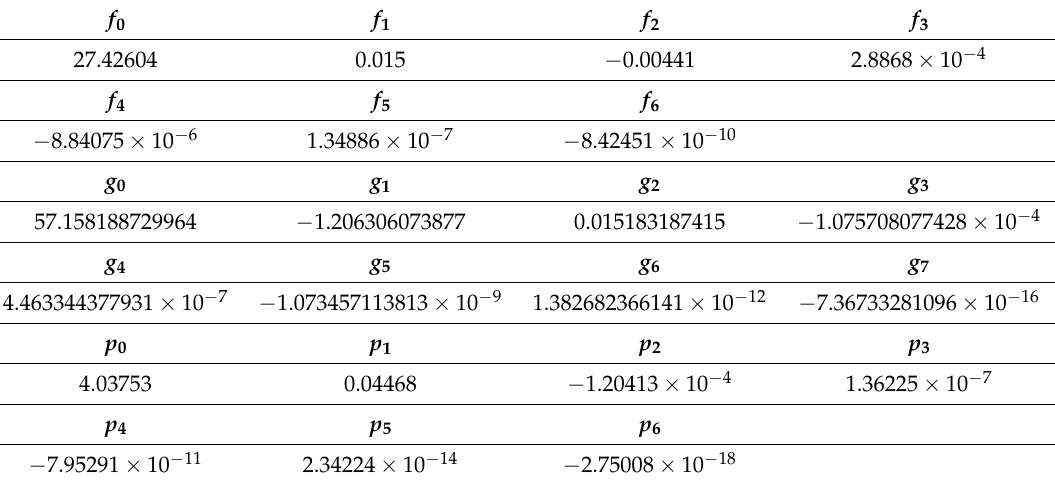
Table 5. The coefficient values for polynomial fitting of T h _ cs .